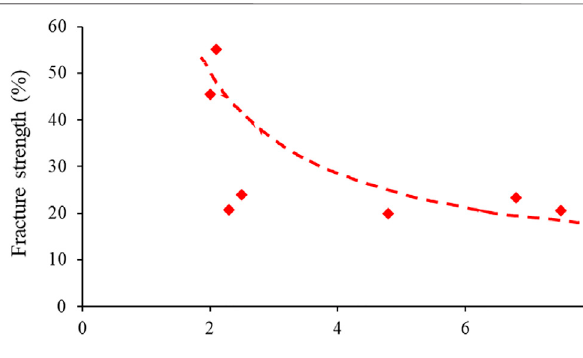
FIGURE 10 | Intersection diagram of distance from well to fault and fracture